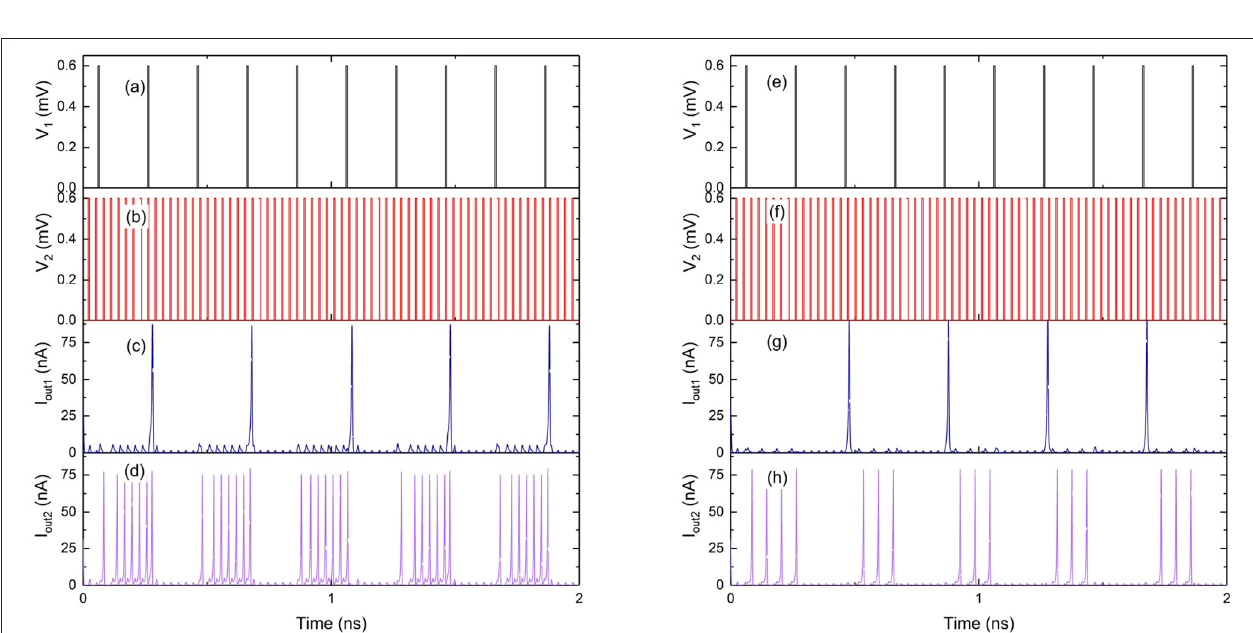
FIGURE 10 | Binary synapse circuit reported in Cheng et al. (2021) reconfigured to operate as a 2 × 2 synapse network.